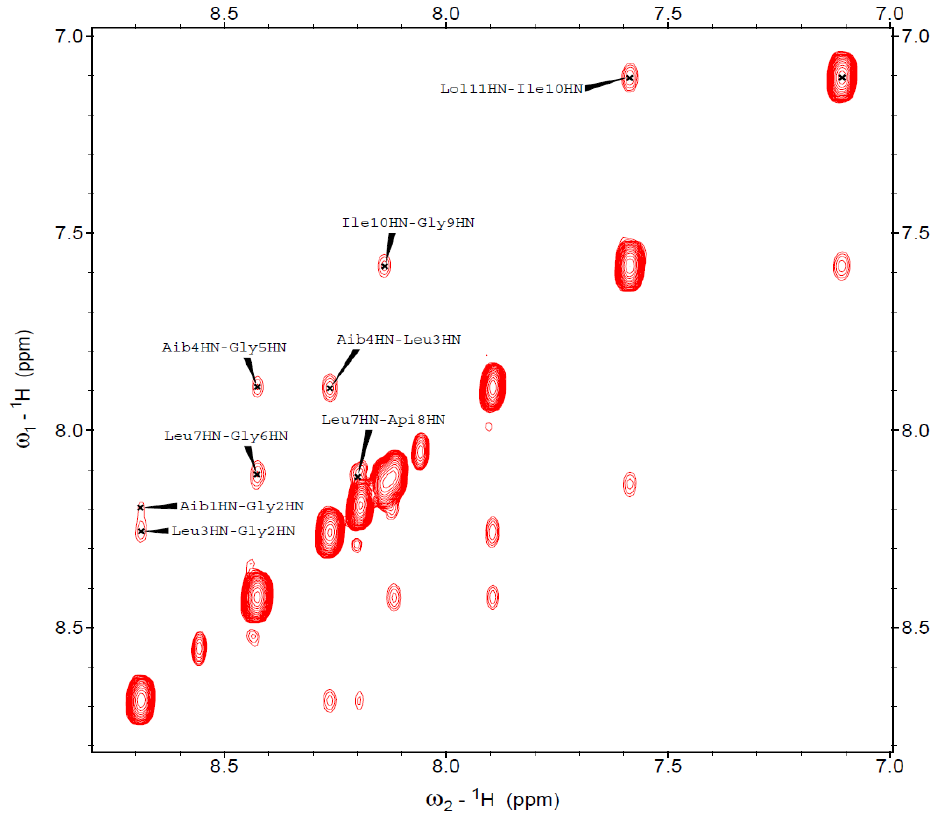
Figure 8. NH amide region of the NOESY spectrum acquired for peptide 8 (600 MHz, 100 mM SDS- d 25 , H 2 O/D 2 O 9:1, pH: 4.5, 313 K). Peptide concentration: 1.66 mM.